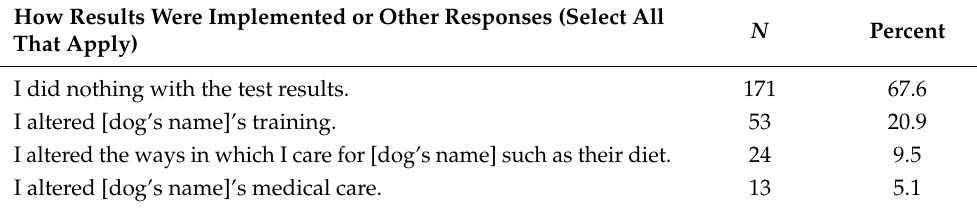
Table 8. Additional context to consumer behavioral responses to their dog’s canine genetic test